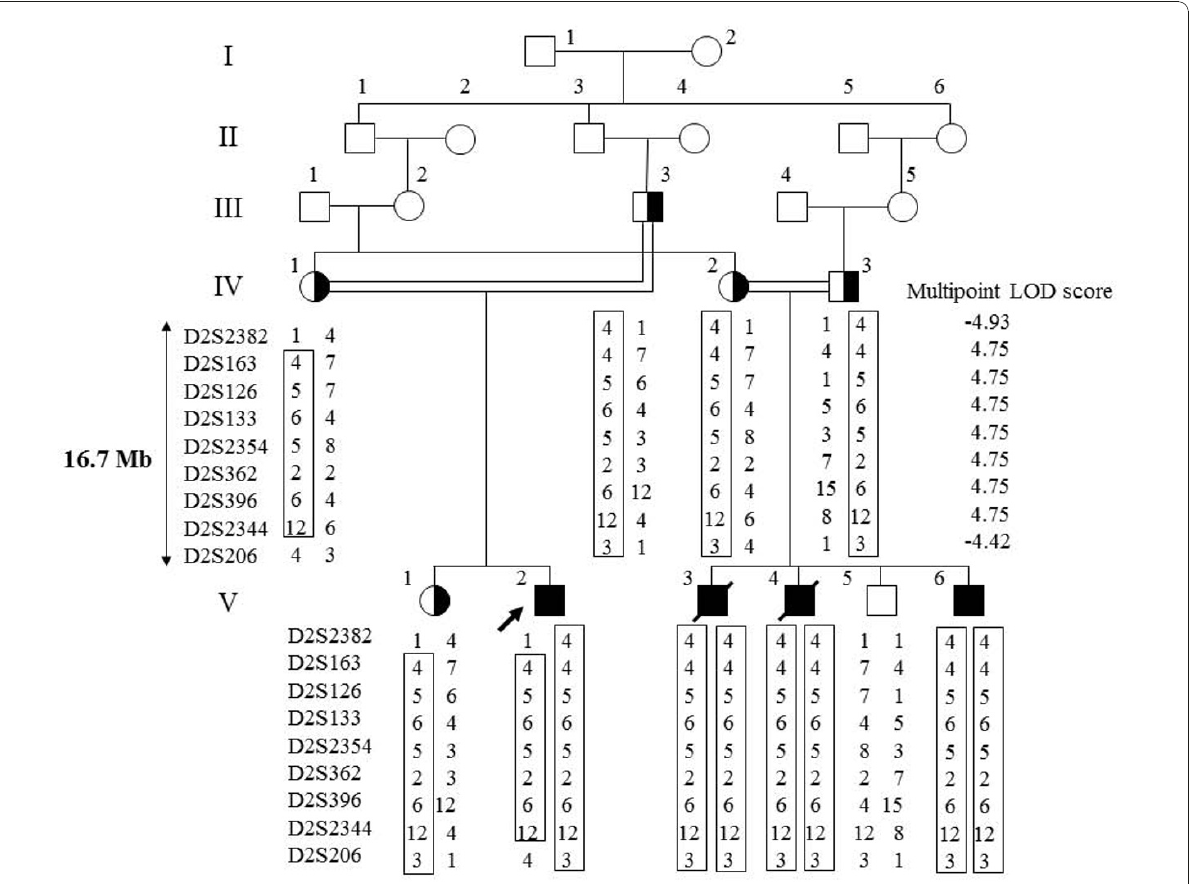
Figure 1 Pedigree and haplotypes in the linkage region . Squares and circles indicate males and females, respectively. The proband and affected individuals are indicated by an arrow and closed symbols, respectively. Only informative markers that define the genetic breakpoints are shown. The maximum LOD score was in the region between D2S163 to D2S2344